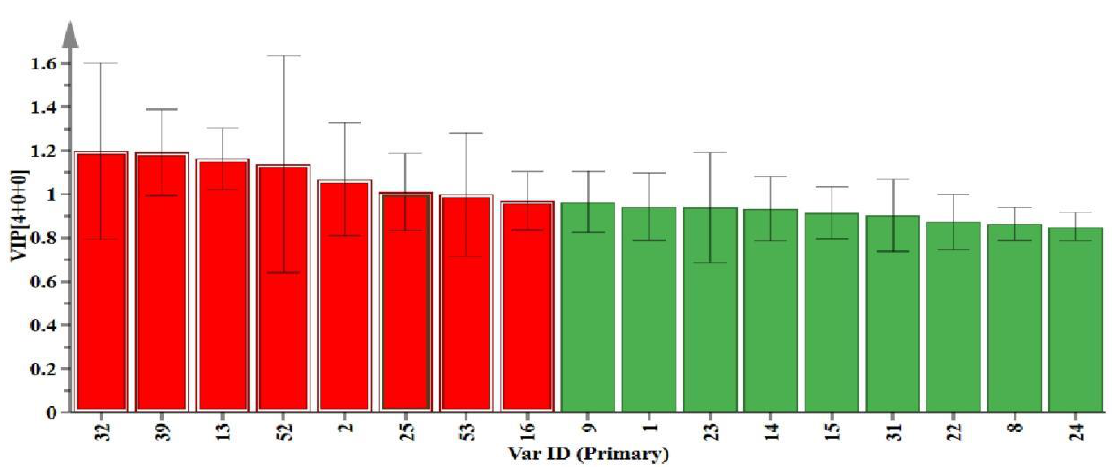
Figure 5. The variable importance in projection (VIP) value of the OPLS-DA model.